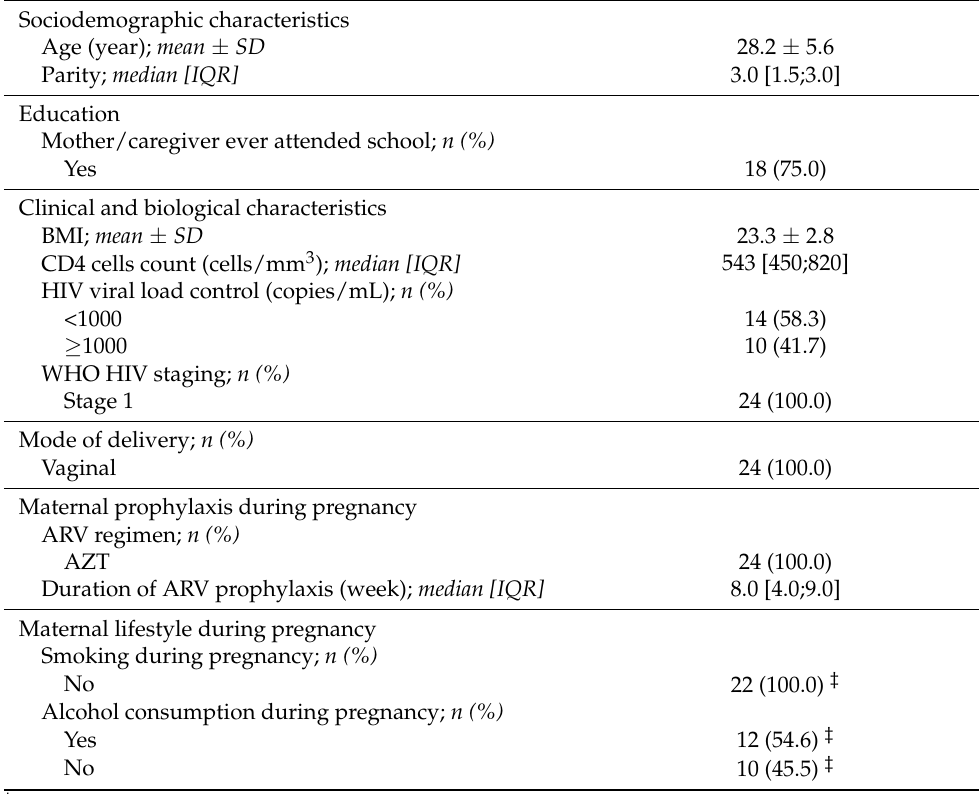
Table 2. Characteristics of the mother at D7 post-partum ( n =